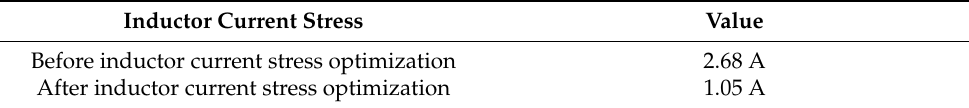
Table 7. Inductor current stress of converter.